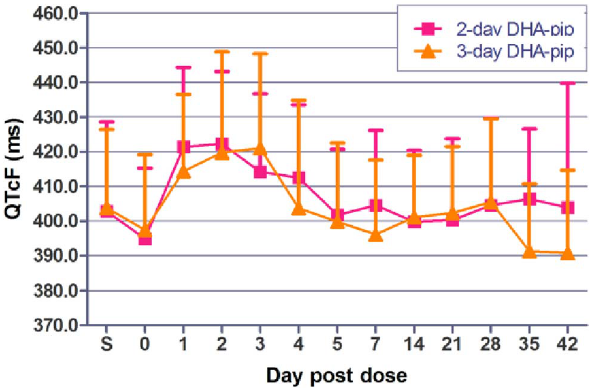
Figure 5. Mean trough QTcF intervals for patients treated daily with DHA-piperaquine (360/2880 mg cumulative) divided over 2 or 3 days (n=40 in each group). Error bars indicate + 1 standard